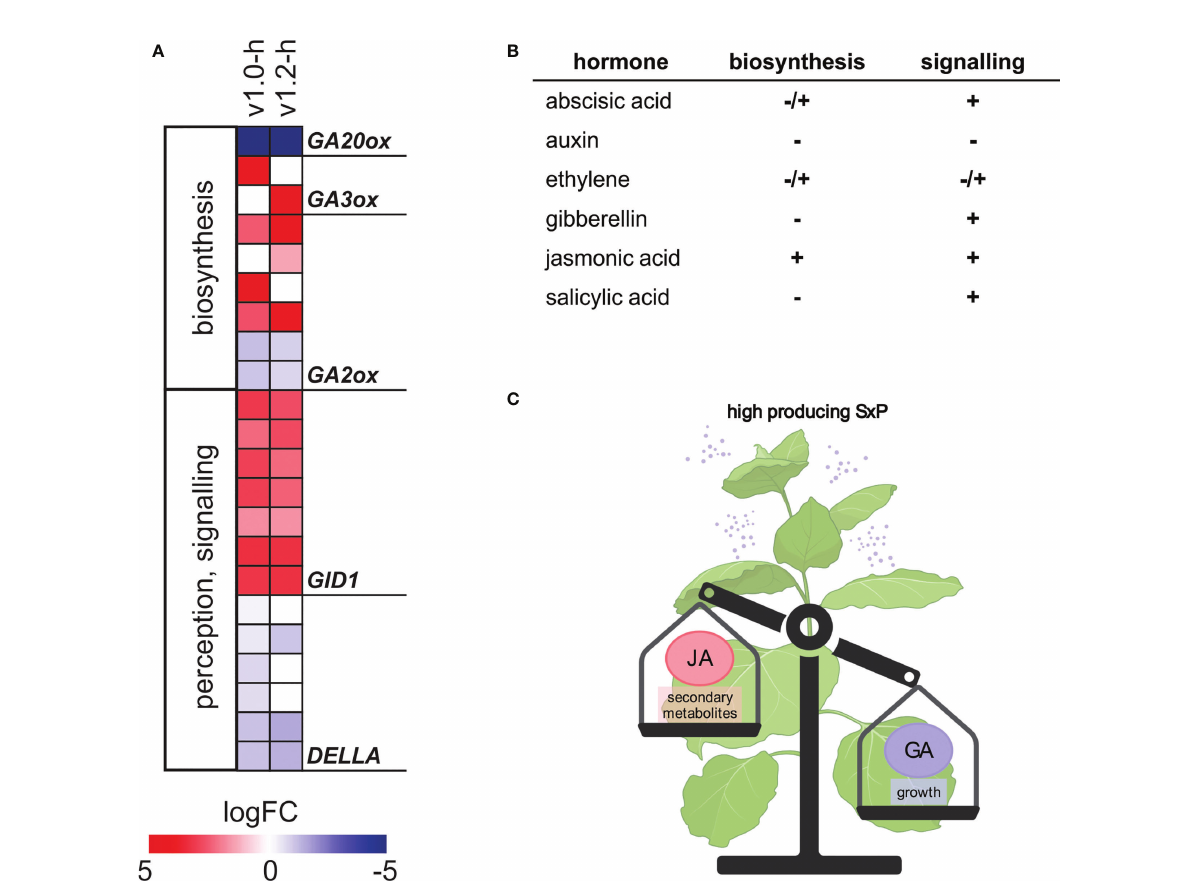
FIGURE 5 Changes in expression of hormone biosynthesis and signalling genes in SxP high producers. (A) Expression of GA-related genes. Colour saturation denotes logFC values, as given on the scale. Only genes with adjusted p-value < 0.05 in at least one group are shown. For the full list of depicted genes, see Supplementary Table S4. (B) Directionality of hormonal regulation, as summarised from results of differential expression analysis and GSEA (Supplementary Data Sheet S1, Supplementary Data Sheet S6). – denotes general downregulation, + denotes general upregulation, and +/- denotes changes in both directions. (C) Schematic representation of the proposed JA-GA interplay behind SxP growth penalty (created with